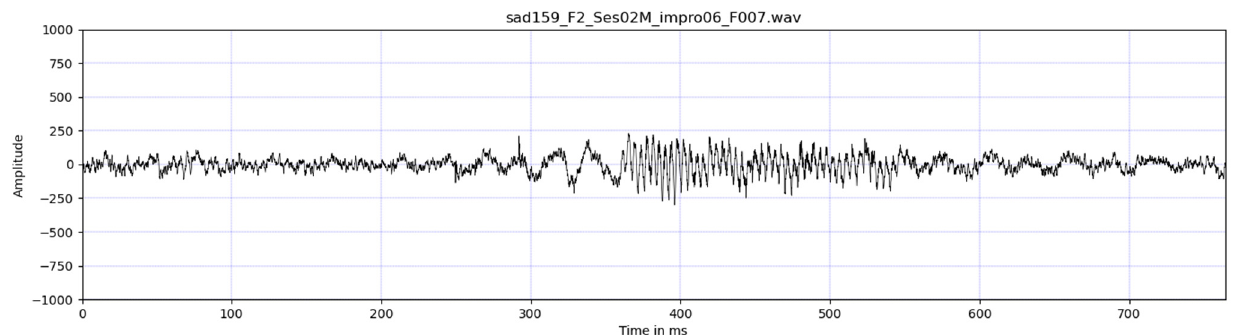
Figure 1. Distribution of sample number for 9 emotions.